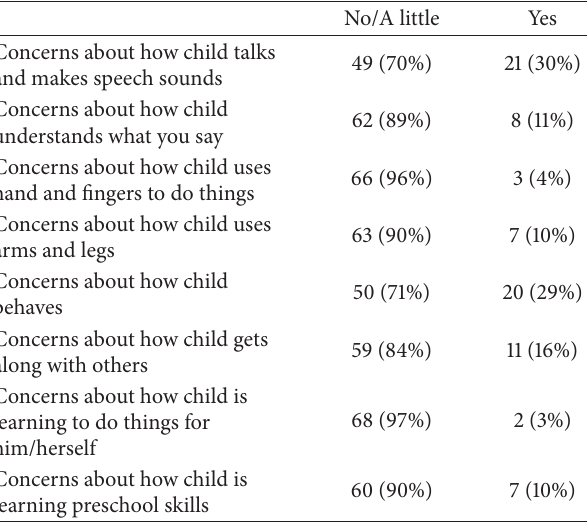
Table 1: Scores on the Parents’ Evaluation of Developmental Status